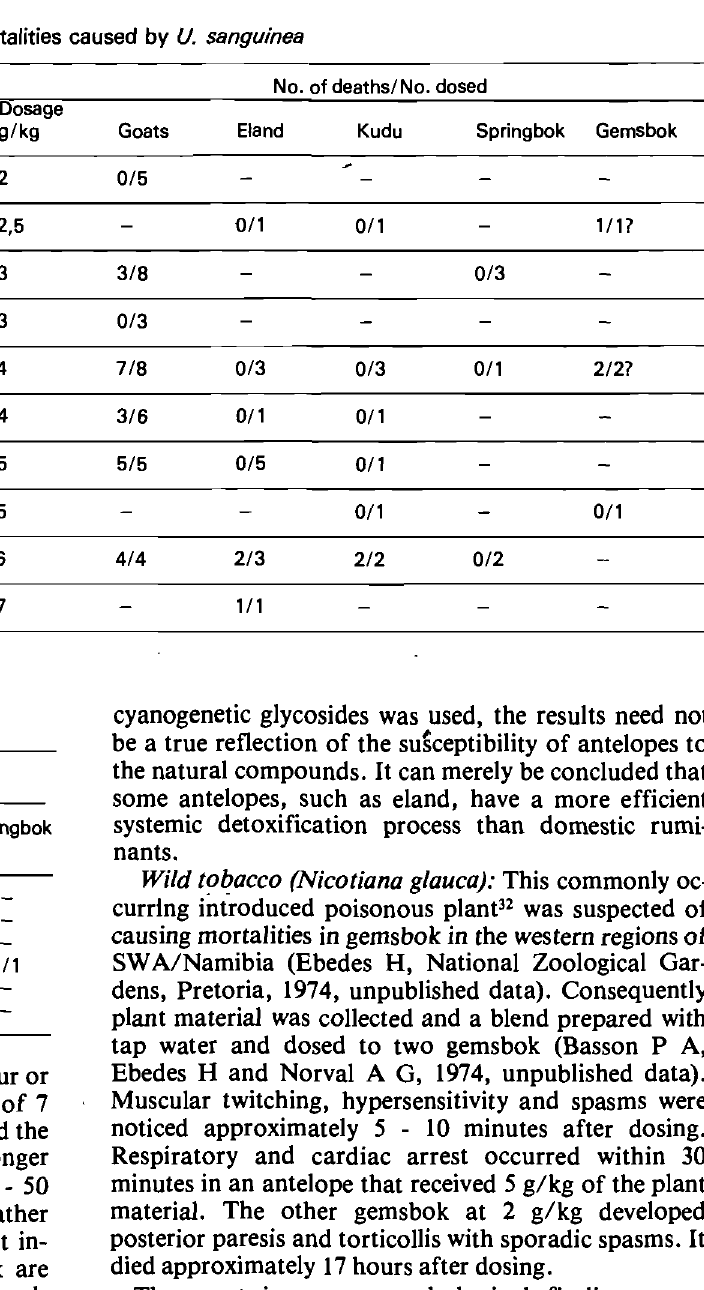
Table 3: Mortalities caused by U. sanguinea